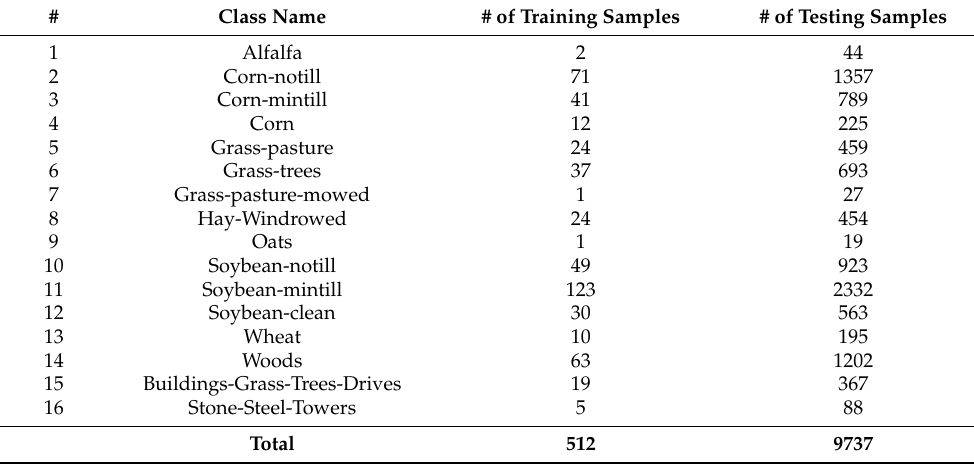
Table 3. Total number of class-specific training and testing samples used for Indian Pines dataset for 5% training